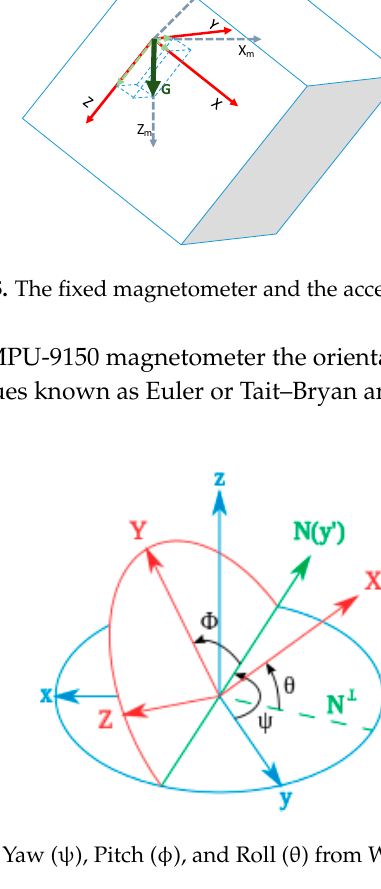
Figure 16. Tait–Bryan angles Yaw ( ψ ), Pitch ( φ ), and Roll ( θ ) from Wikimedia (author: Juansempere).